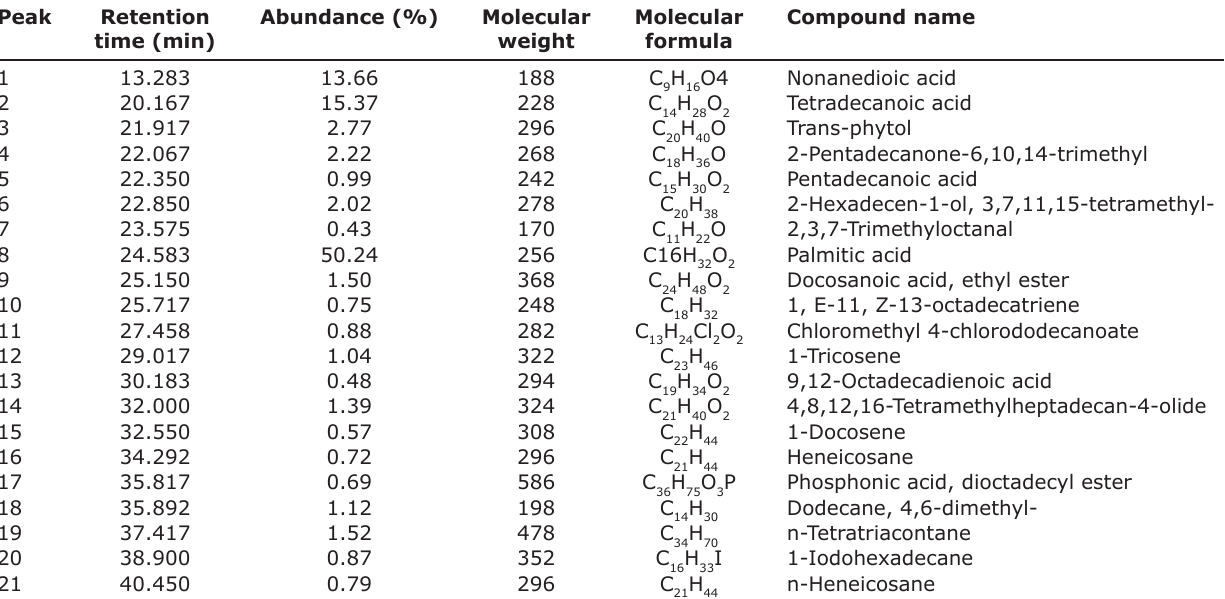
Figure-2: Gas chromatogram of the anticancer isolate of Xestospongia testudinaria sponge. Table-4: Compounds identified in the anticancer isolate of X. testudinaria sponge. Peak Retention Abundance (%) Molecular time (min)